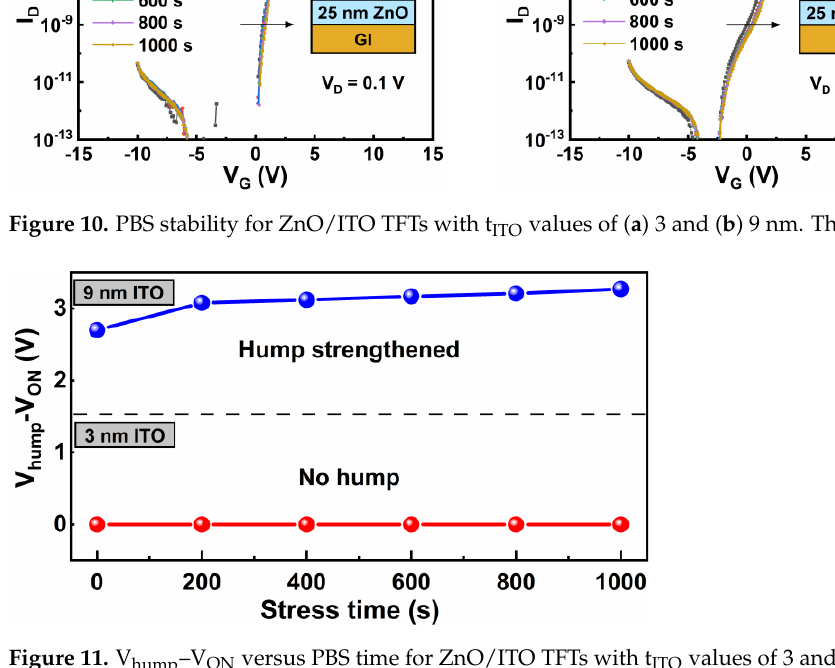
Figure 11. V hump – V ON versus PBS time for ZnO/ITO TFTs with t ITO values of 3 and 9 nm. The t ZnO value is 25 nm.